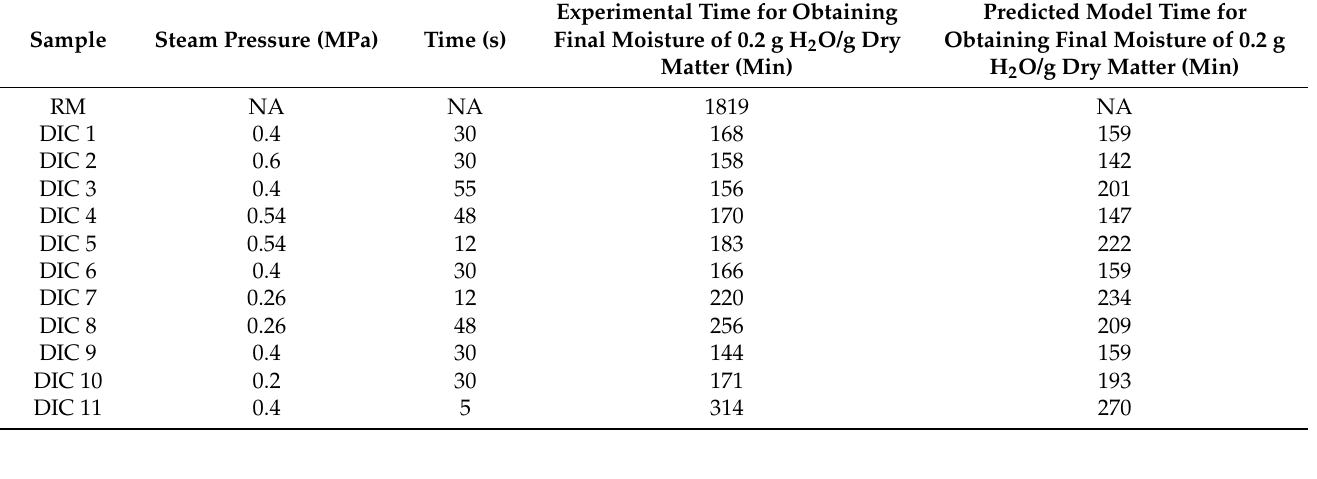
Table 7. Experimental data and predicted model results of Time for obtaining a final moisture content of 20% d.b.